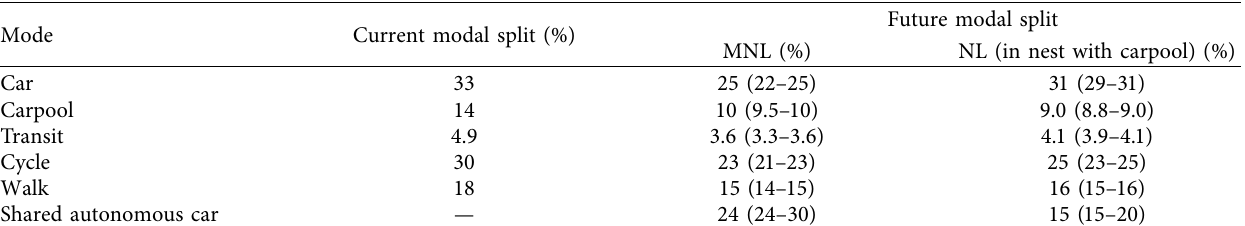
Table 11: Calculated modal split for a shared autonomous car with sensitivity analysis ranges between brackets based on a 20% variation of all mode